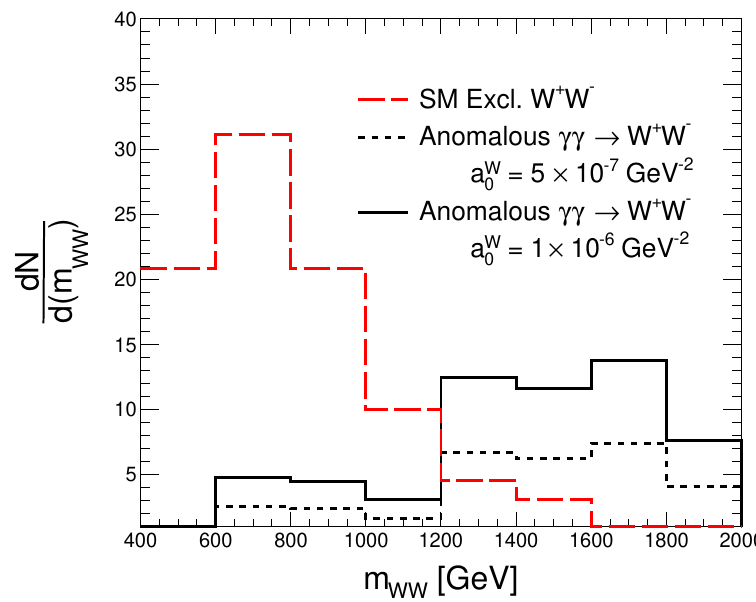
Figure 9 . Leading (left) and second leading (right) large-radius jet p T for the γγ → W + W − process, where each W boson decays hadronically. The anomalous contribution is shown in black solid and dashed lines, which represent two different values of anomalous coupling a W and a W = 10 − 6 GeV − 2 with fixed a W = 0 . The SM γγ → W + W − contribution is shown in the red 0 C dashed line (after time-of-flight requirement, normalized to 300 fb − 1 of luminosity). No matching cut in rapidity or mass is applied for these plots.